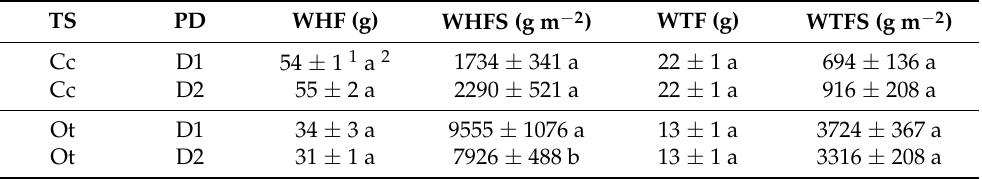
Table 6. Estimated biometric marginal mean differences calculated with the Bonferroni adjustment between the density treatments relative to weights of flower heads and tubules.